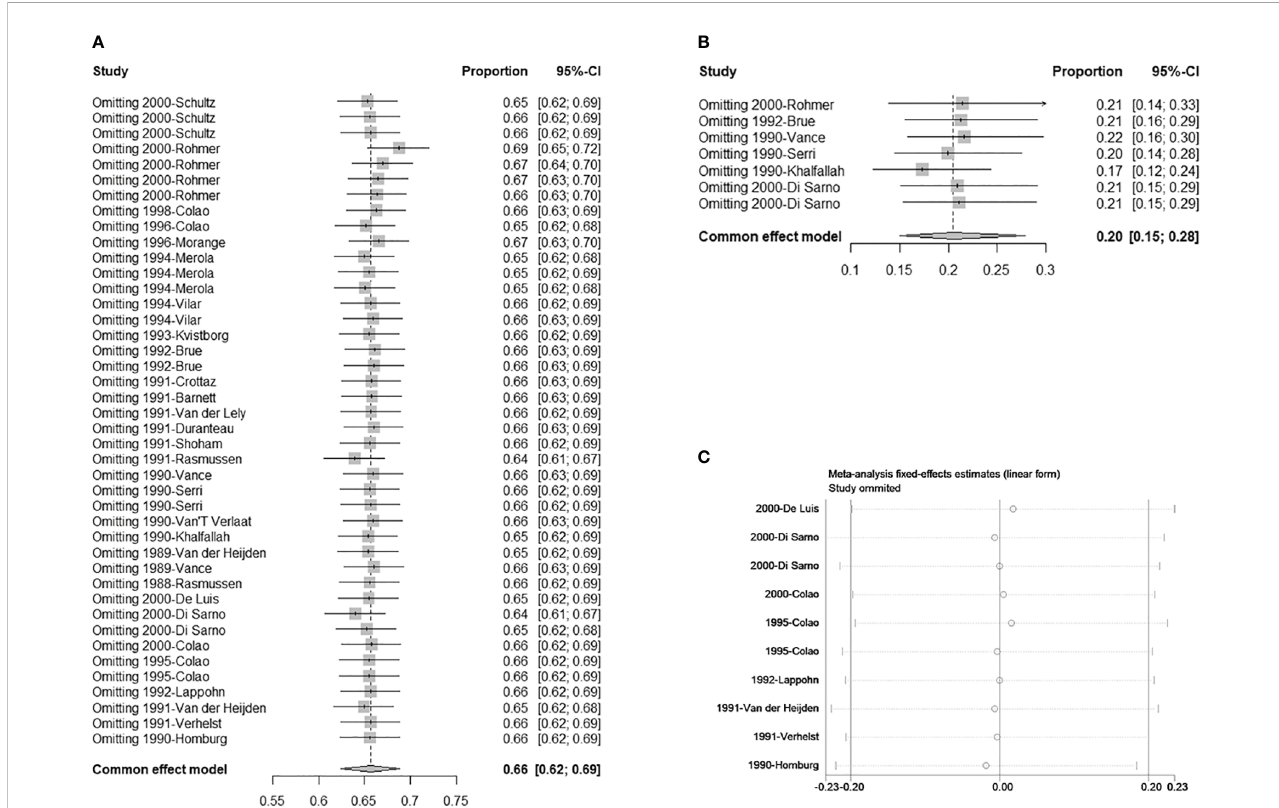
FIGURE 3 Sensitivity analysis. (A) Single-armed studies related to hyperprolactinemia treatment; (B) Single-armed studies related to prolactinoma treatment; (C) Double-armed